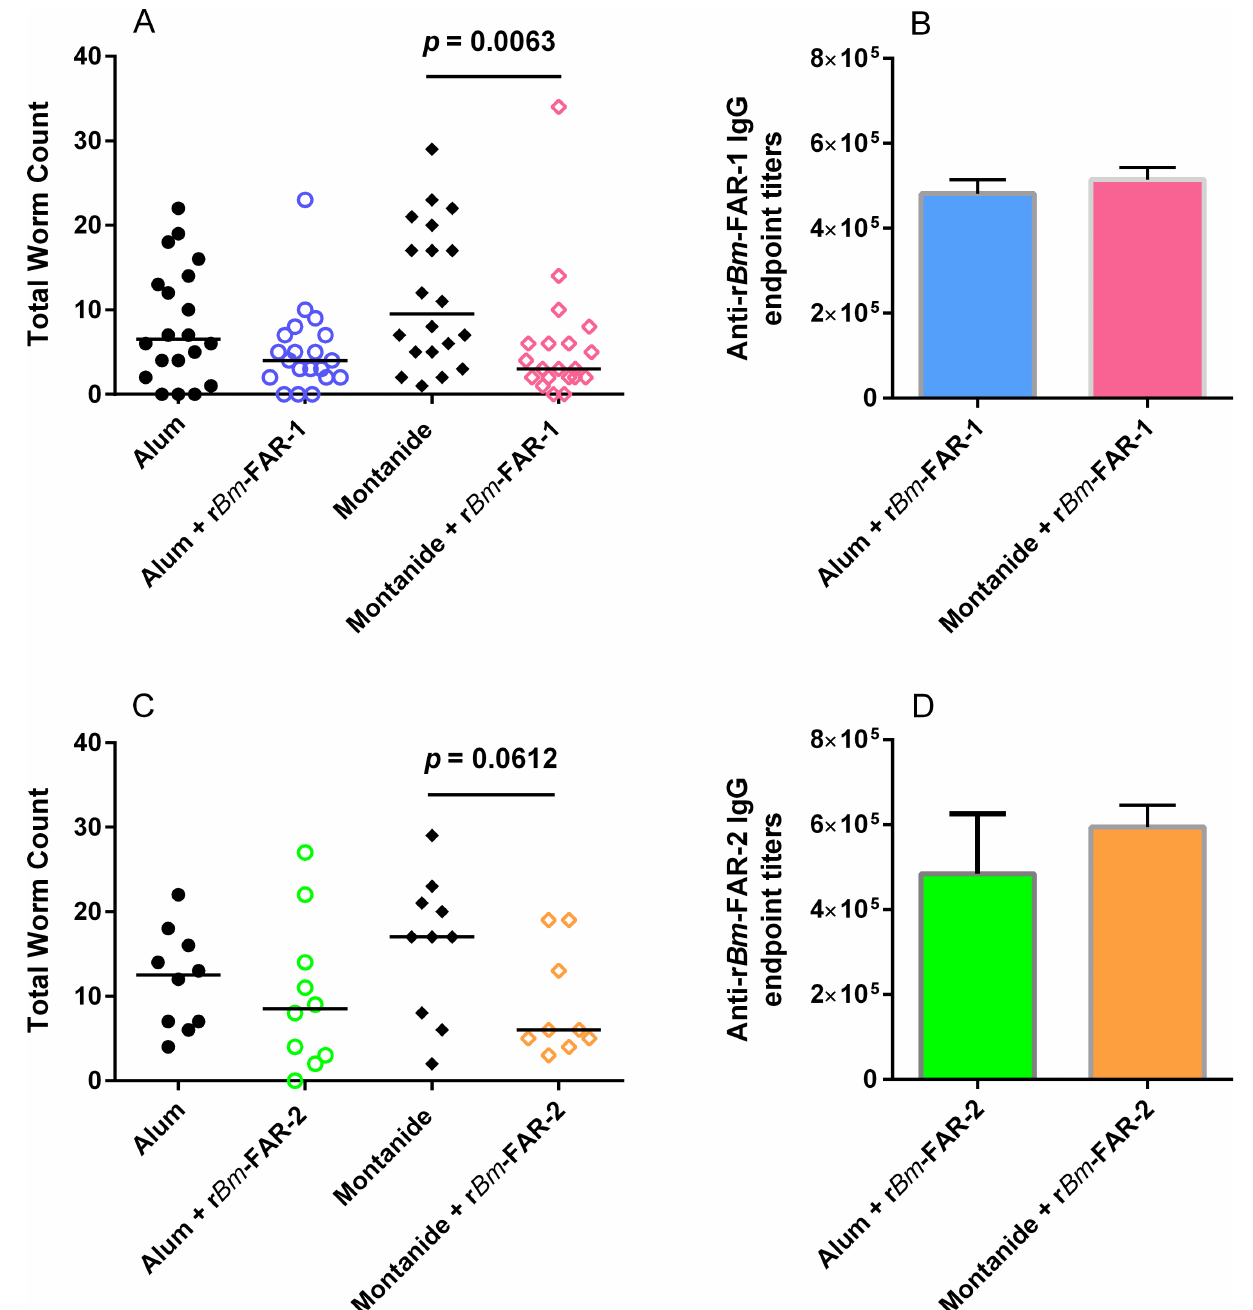
Fig 7. Protective immunity induced by immunization of gerbils with r Bm- FAR-1 and r Bm- FAR-2 formulated with Montanide-720 or alum. ( A) Total worm count from gerbils (n = 20 per group, which are presented as a combination of two separate experiments) immunized with r Bm- FAR-1 formulated with alum or Montanide-720 or adjuvant controls 42 days after being challenged with 100 B . malayi L3. ( B) Titers of anti- Bm- FAR-1 IgG in sera of gerbils immunized r Bm- FAR-1 formulated with alum or Montanide-720. ( C) Total worm count from gerbils (n = 10 per group performed only once) immunized with r Bm- FAR-2 formulated with alum or Montanide-720 or adjuvant controls. ( D) Titers of anti- Bm- FAR-2 IgG in sera taken from gerbils immunized with r Bm- FAR-2 formulated with alum or Montanide-720. The median in A and C is marked by a line. Geometric mean and 95% CI are marked in B and